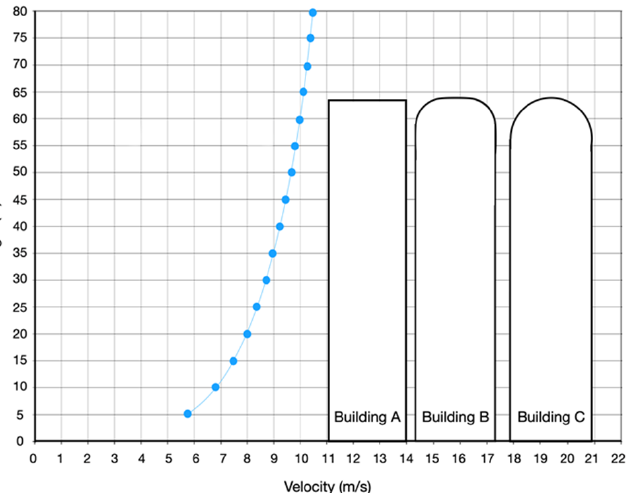
Figure 3. The wind velocity profile from the Power Law Equation (2) in terrain B at the height of the building (scale 1:150).